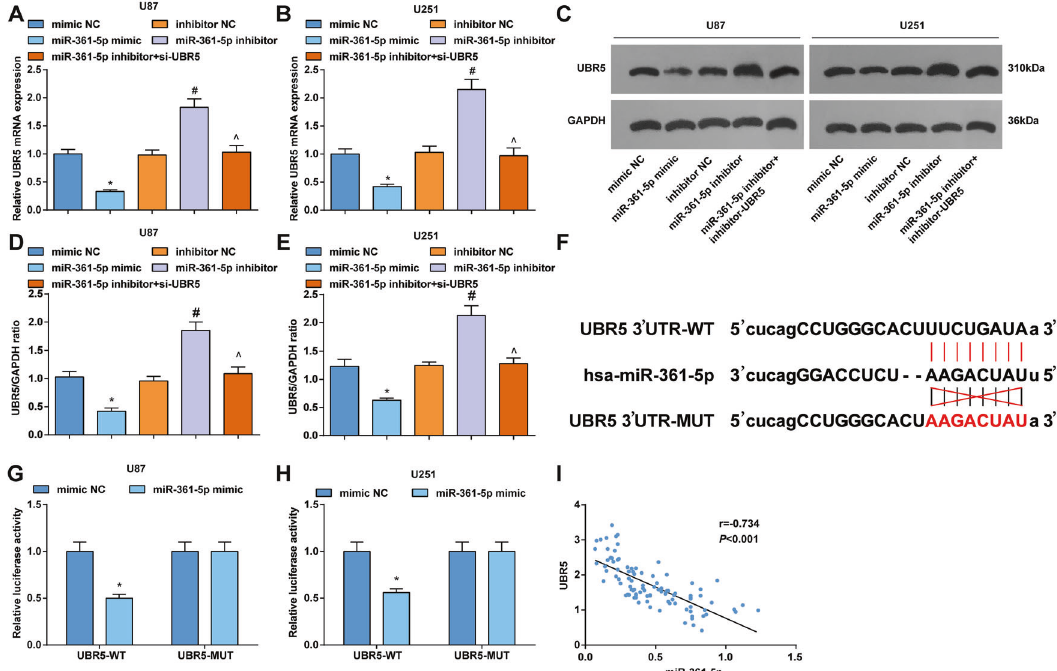
Fig. 4 UBR5 is directly targeted by miR-361-5p. A RT-qPCR tested UBR5 mRNA expression in U87 cells. B RT-qPCR tested UBR5 mRNA expression in U251 cells. C Western blot tested UBR5 protein bands in U87 and U251 cells. D Western blot tested UBR5 protein expression in U87. E Western blot tested UBR5 protein expression in U251 cells. F Starbase predicted the binding sites of miR-361-5p and UBR5. G Dual- luciferase reporter gene assay veri fi ed the targeting relation of miR-361-5p and UBR5 in U87 cells. H Dual-luciferase reporter gene assay veri fi ed the targeting relation of miR-361-5p and UBR5 in U251 cells. I Correlation analysis between miR-361-5p expression with UBR5 expression in gliomas cells. The data were all measurement data, in the form of mean ± standard deviation; * P < 0.05 compared with the mimic NC group; * P < 0.05 compared with the inhibitor group; ^ P < 0.05 compared with the miR-361-5p inhibitor